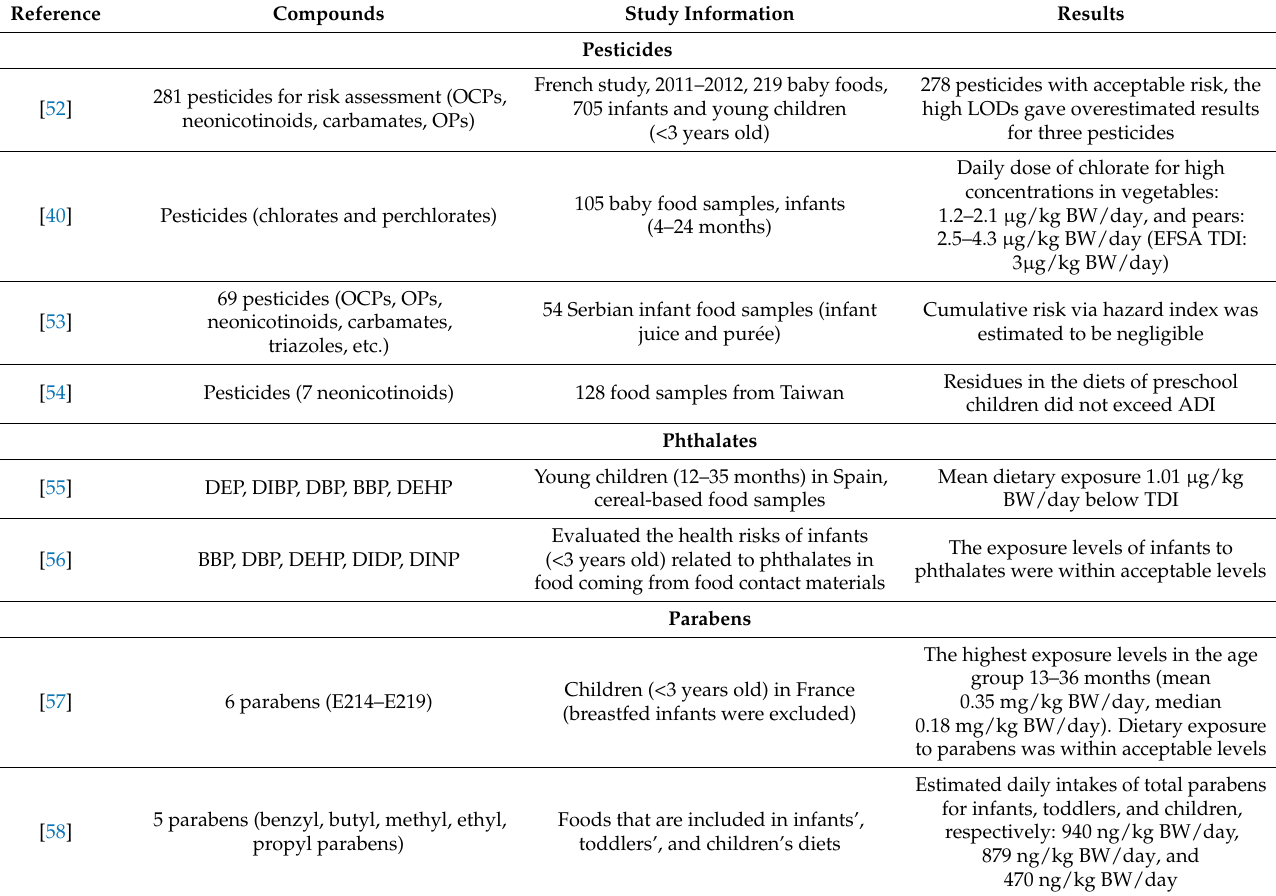
Table 2. Results of risk assessments from studies in literature for several categories of